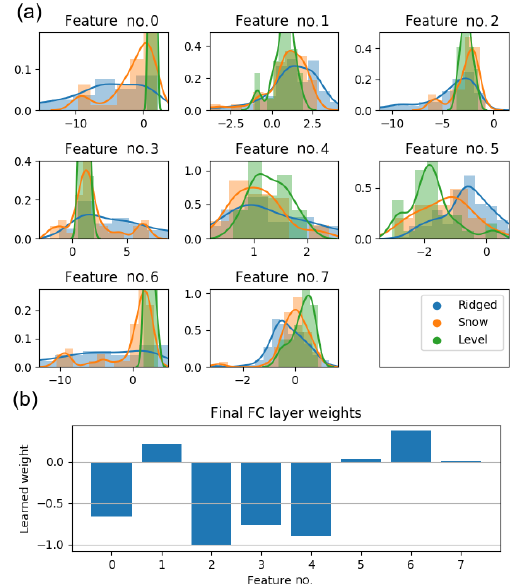
Figure 12. (a) Distribution of the final (8 × 1) layer activations for the level, ridged and snow categories from Fig. 7, and (b) the learned weights for the final fully connected hidden layer. To gener- ate the final thickness estimate, the activations in (a) are multiplied with the weights in (b) and then summed.